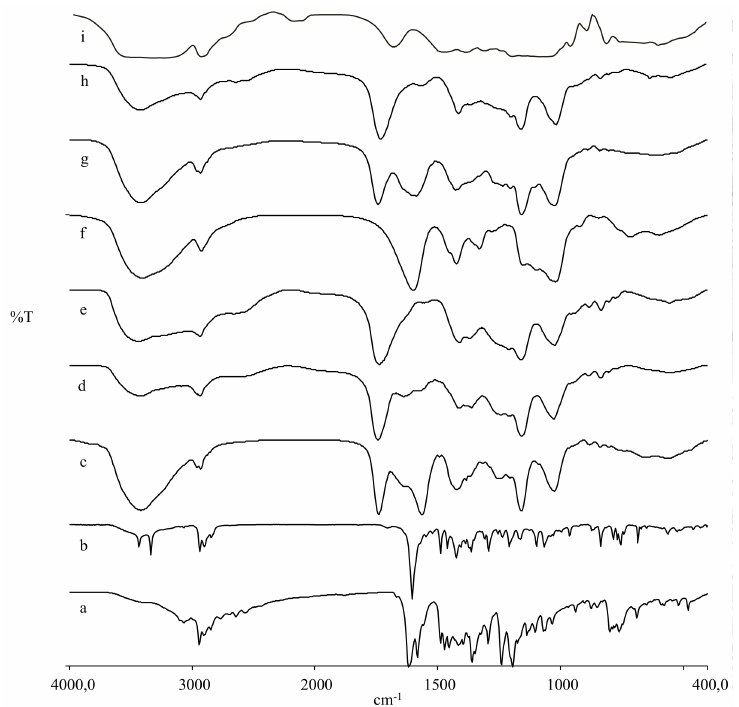
Figure 4. FT-IR spectra of dextran, TSPO ligands, carboxylated dextran derivatives and TSPO ligand